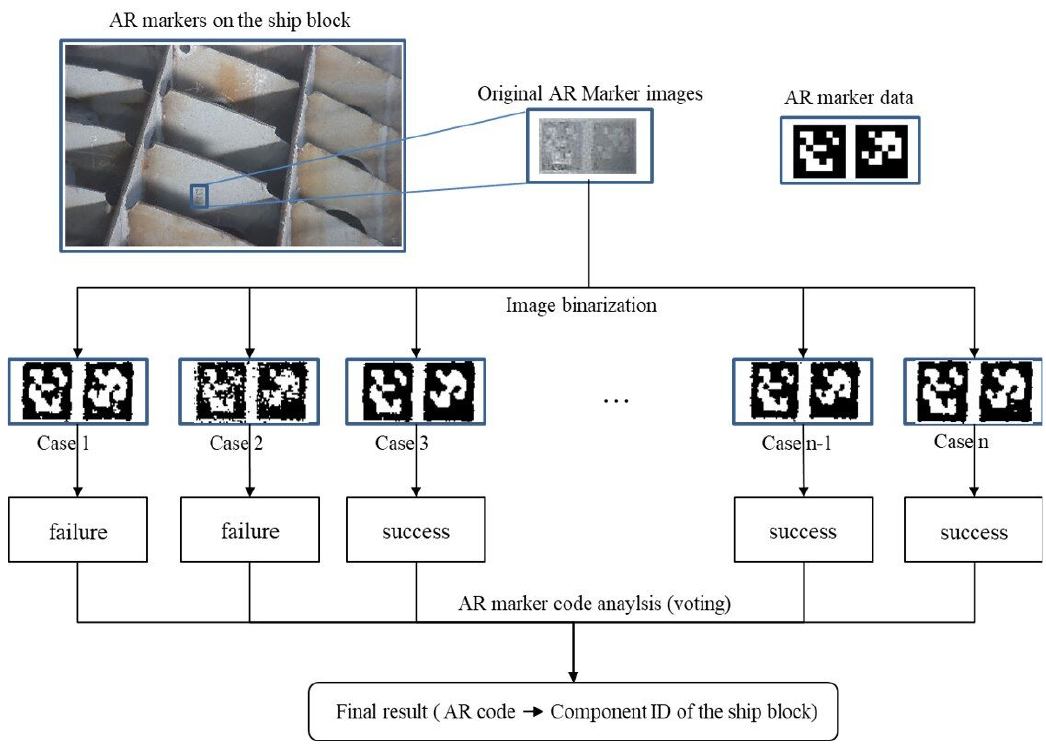
Figure 9. Procedure for AR marker